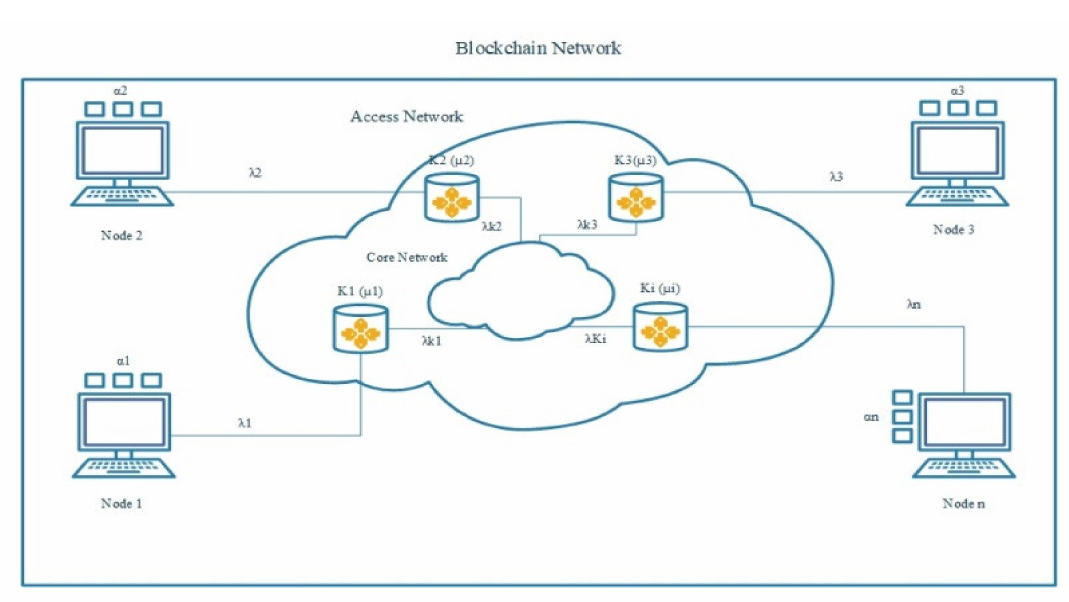
Figure 3. A blockchain tra ffi c flow